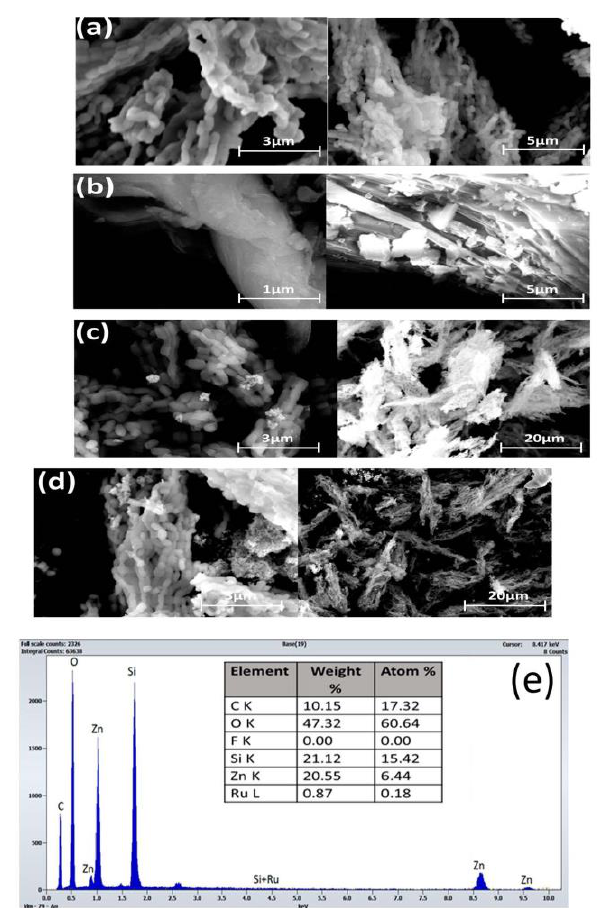
Figure 1. SEM images ofthe as-prepared ( a ) SBA-15; ( b ) ZnO; ( c ) ZnO/SBA-15;( d ) Ru-ZnO/SBA-15; ( e ) and EDX of Ru-ZnO/SBA-15.